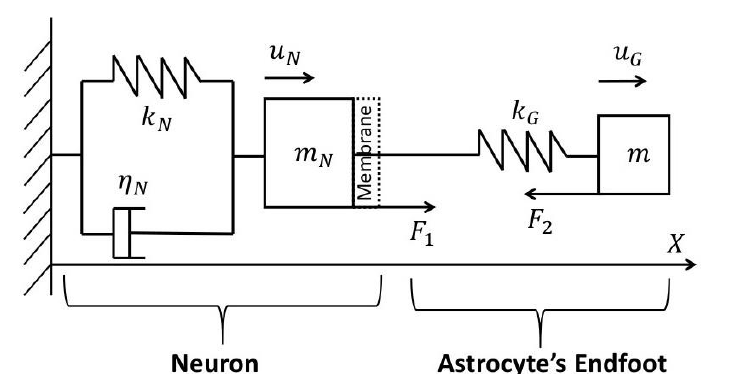
Figure 3. Schematic of a brain-on-a-chip made of a coupled neuron (modeled as a linear viscoelastic Kelvin-Voigt element connected to a mass) and astrocyte’s endfoot (modeled as a spring-mass mechanical system). Forces 𝑭 𝟏 and 𝑭 𝟐 are assumed to be proportional to the concentration of NO. The opposite directions of these forces compress the spring in the spring-mass system which is assumed to model vasodilatation. The deformation of the neuron is caused by the action of the applied force 𝑭 𝟏 and the mechanical response of the neuron to action potentials triggered by an externally applied current 𝑰